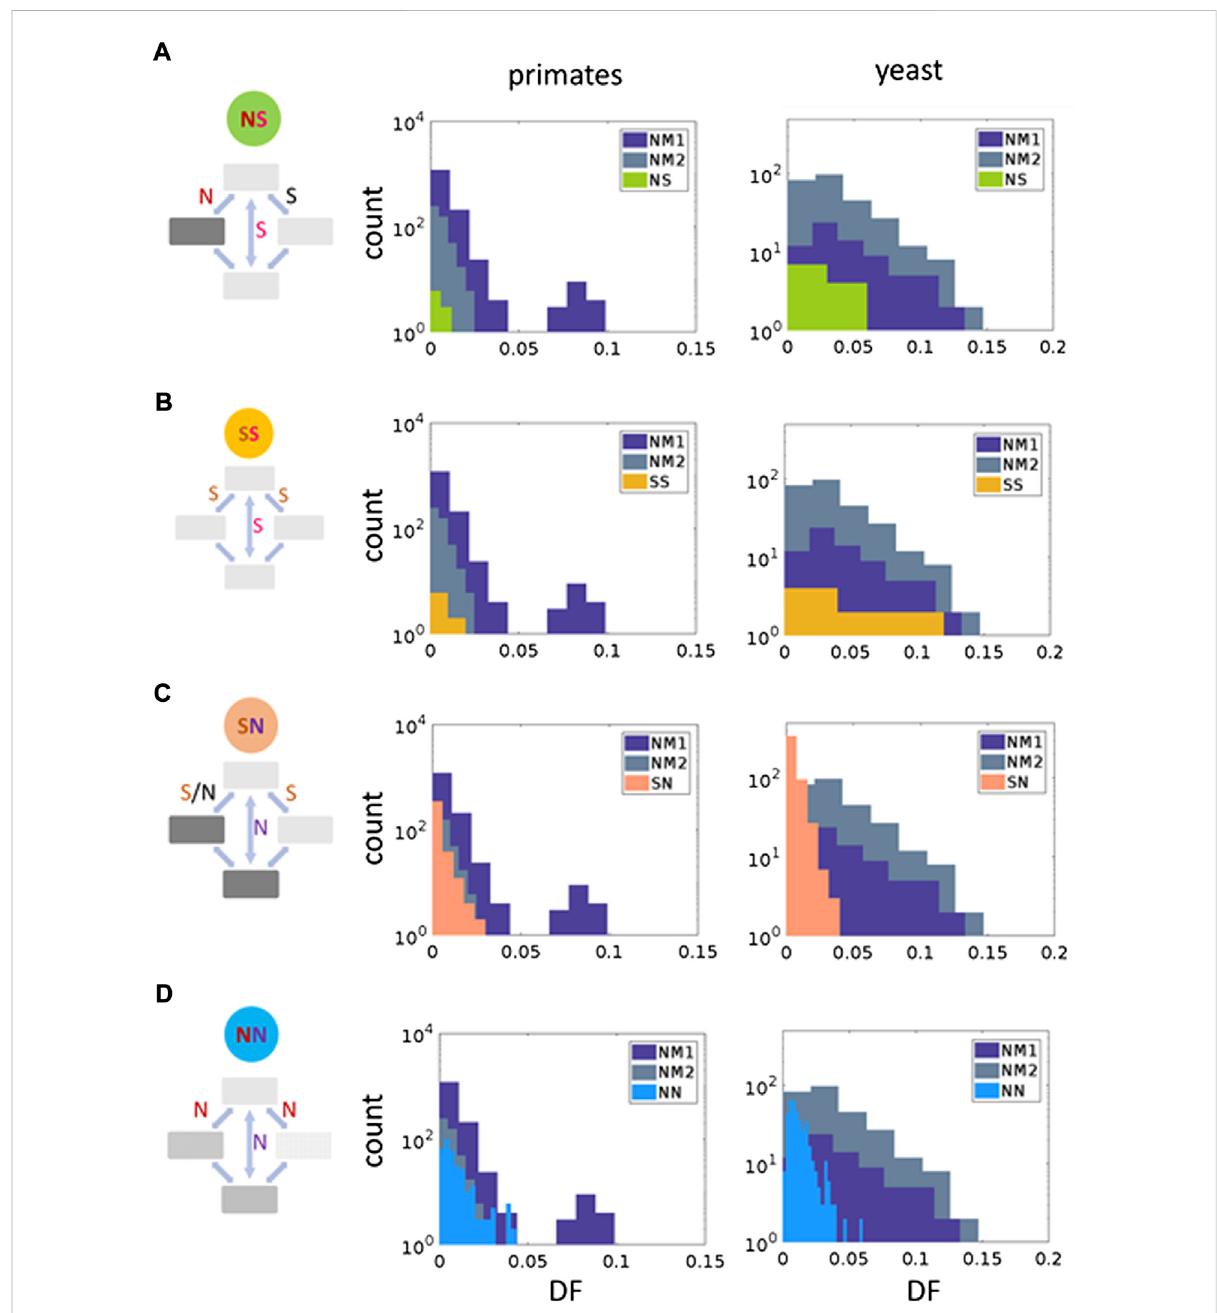
FIGURE 3 S elective regimes of the codon double substitutions in primates and yeasts. Right panels show a classi fi cation of codon double substitution basedonthesynonymyoftheancestralvs.the fi nalcodonstate,andthesynonymyoftheancestraltotheintermediatecodons.Twoleftpanelsshow comparisons ofDFforeachcodondoublesubstitutionclasstothedoublesynonymous nullmodels(NM1andNM2)usingtheMann – WhitneyUtest. (A) NS,onenon-synonymousintermediate,synonymous fi nalcodon.Primates:NM1 p -value=0.77,NM2 p -value=0.72.Yeasts:NM1 p -value= 0.06, NM2 p -value = 0.25. (B) SS, double synonymous codon substitutions. Primates: NM1 p -value = 0.42, NM2 p -value = 0.17. Yeasts: NM1 p -value = 0.82, NM2 p -value = 0.45. (C) SN, at least one synonymous intermediate codon, non-synonymous fi nal codon. Primates: NM1 p -value=2.38×10 − 63 ,NM2 p -value=8.73×10 − 34 .Yeasts:NM1 p -value=4.28×10 − 38 ,NM2 p -value=5.64×10 − 98 . (D) NN — bothintermediates and the fi nal codon are non-synonymous to the ancestral. Primates: NM1 p -value = 0.059, NM2 p -value = 2.53 × 10 − 5 . Yeasts: NM1 p -value = 7.16 × 10 − 27 , NM2 p -value = 5.61 × 10 − 56